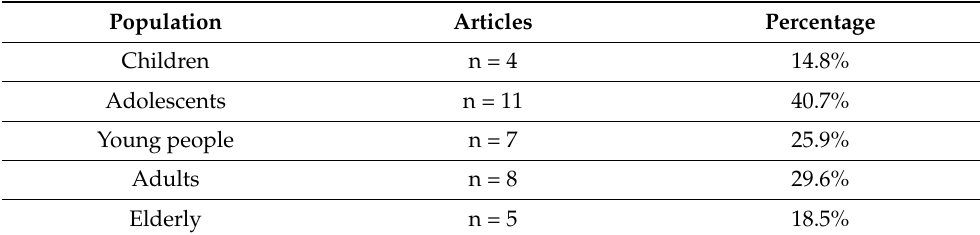
Table 3. Populations examined by included studies.